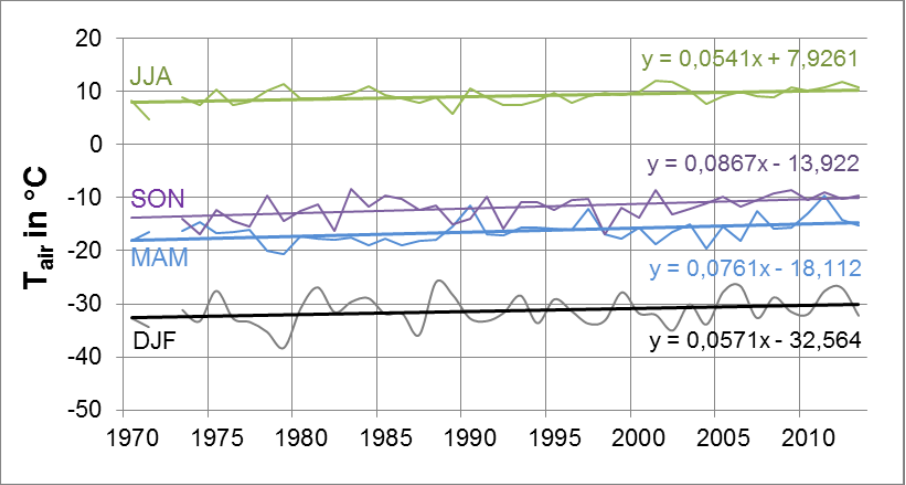
Figure 6. Air-Temperature time series divided by seasons (winter—DJF; spring—MAM, summer—JJA and fall—SON) of the meteorological station Khatanga at the Taymyr Peninsula (71.9°N, 102.5°E)—Additional stations are shown in the supplementary material (Figure